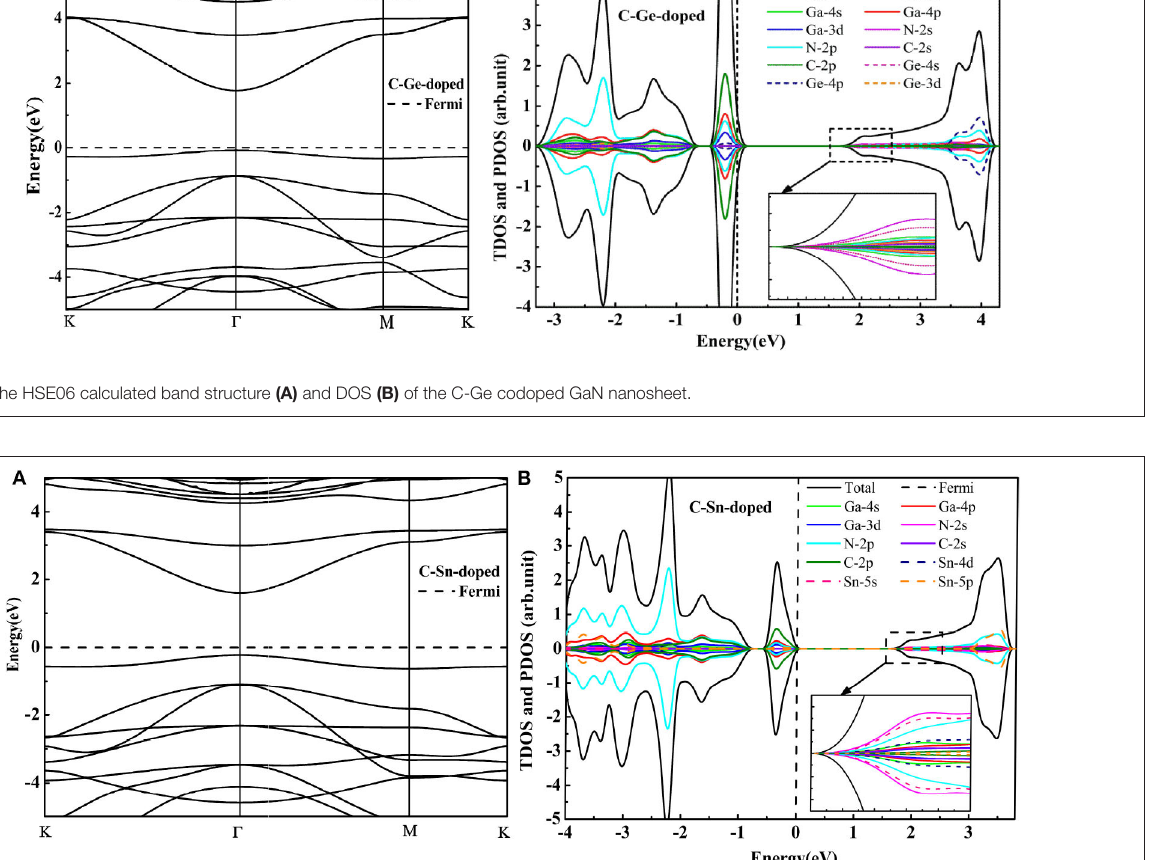
FIGURE 4 | The HSE06 calculated band structure (A) and DOS (B) of the C-Sn codoped GaN nanosheet.